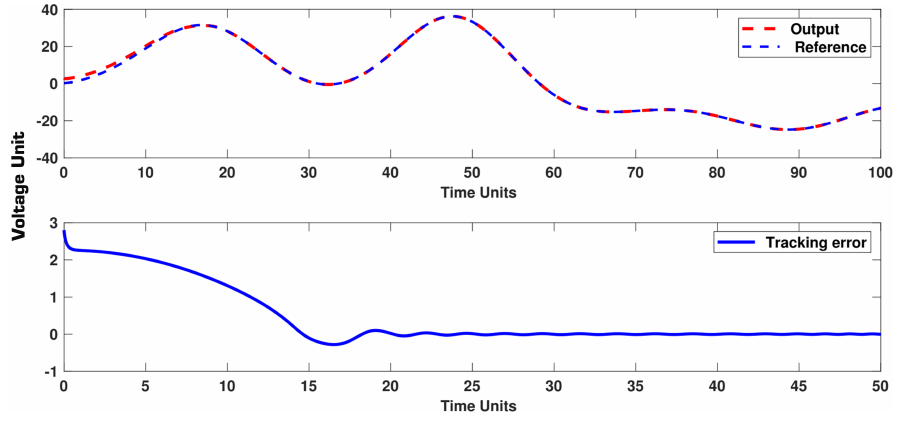
Figure 6. Example 2: Output and error signals.